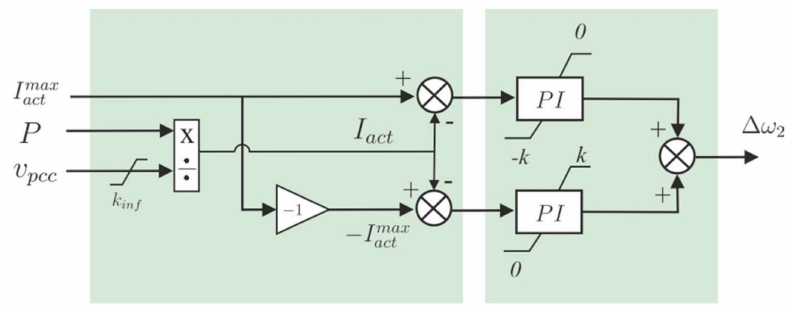
Figure 6. Active current limiting (ACL)